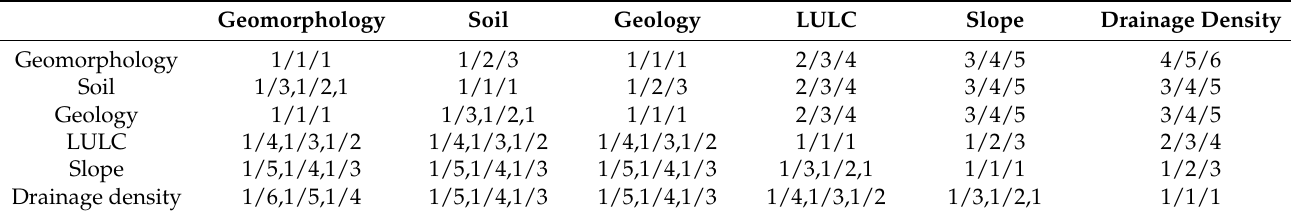
Table 4. Pairwise comparison matrix for six themes.